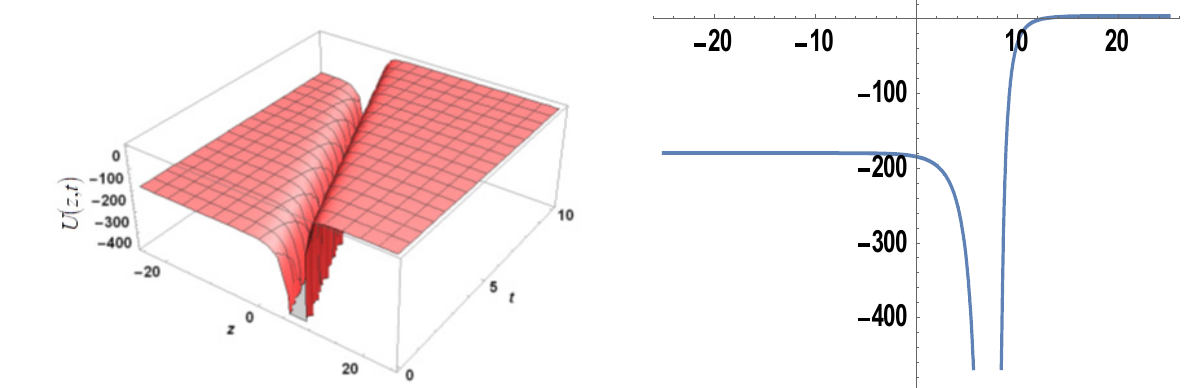
Figure 2. The 3D and 2D plots of Equation (52) for various values of parameters.